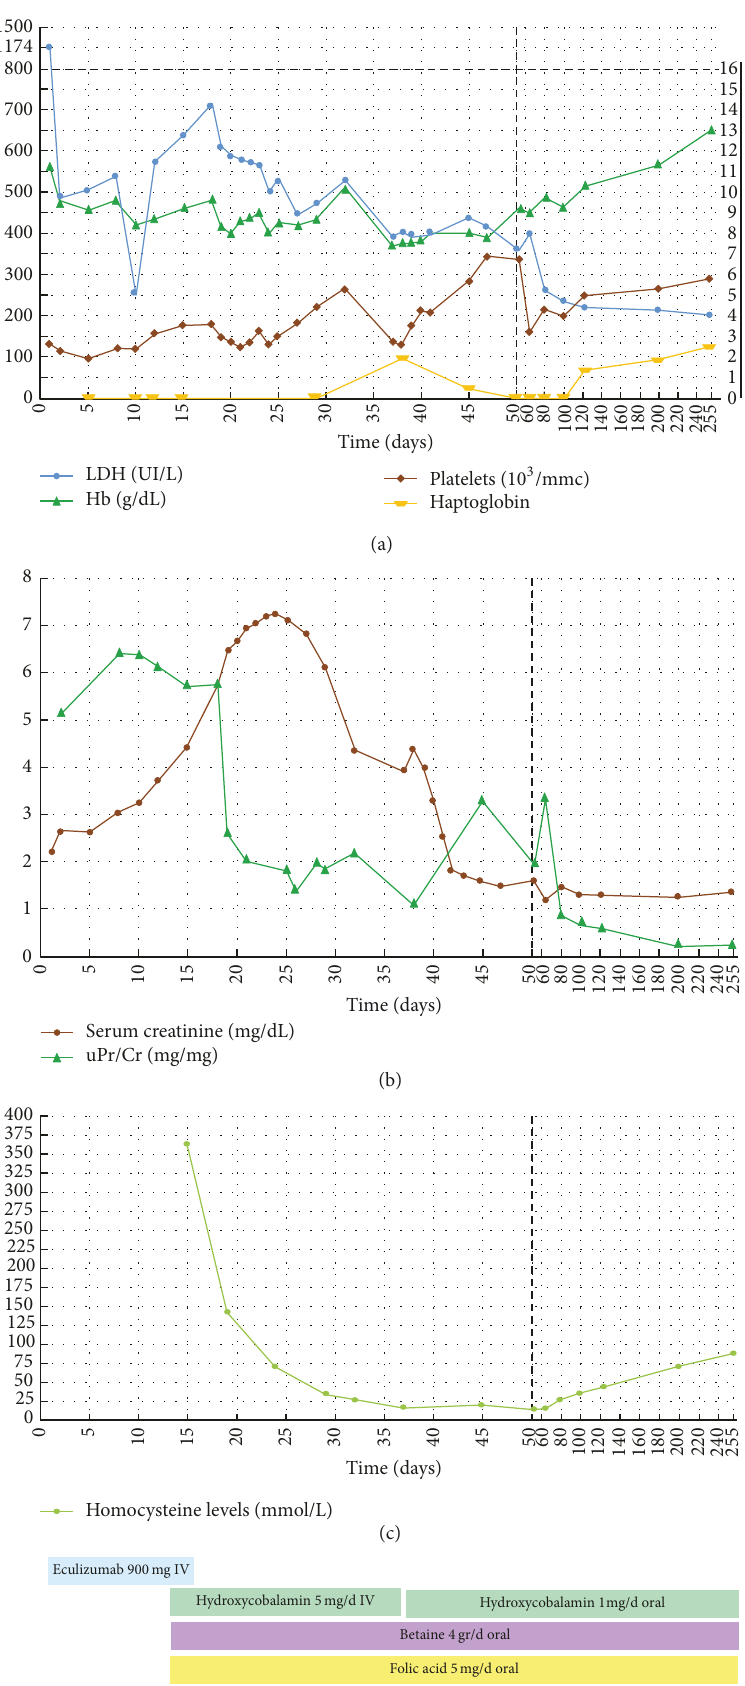
Figure 1: Laboratory relevant to TMA activity. (a) Hematological parameters: LDH (UI/L); Hb (g/dL); platelets (10 3 /mmc); (b) renal parameters: serum creatinine (mg/dL); uPr/Cr (mg/mg); (c) homocysteine levels